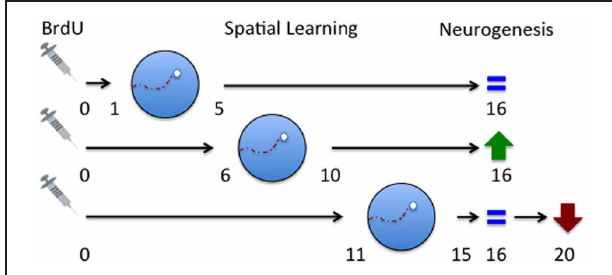
FIGURE 2 | Critical periods for spatial learning induced changes in immature cell survival in the dentate gyrus. Spatial learning does not impact the survival of immature neurons that are 1–5 days old at the time of learning. Survival of immature neurons that are 6–10 days old during training is selectively enhanced [although this can depend on task difficulty (Epp and Galea, 2009) and quality of learning (Epp et al., 2007; Sisti et al., 2007)]. Survival of immature neurons that are 15–20 days old at the time of learning is decreased. This effect cannot be detected if animals are perfused the day following training but can be observed if histological examination is delayed until day 20 following a probe trial 90min before perfusion. Collected from findings from Epp et al. (2007 and 2011a). Described changes in neurogenesis are in comparison to rats trained on a cued version of the task.